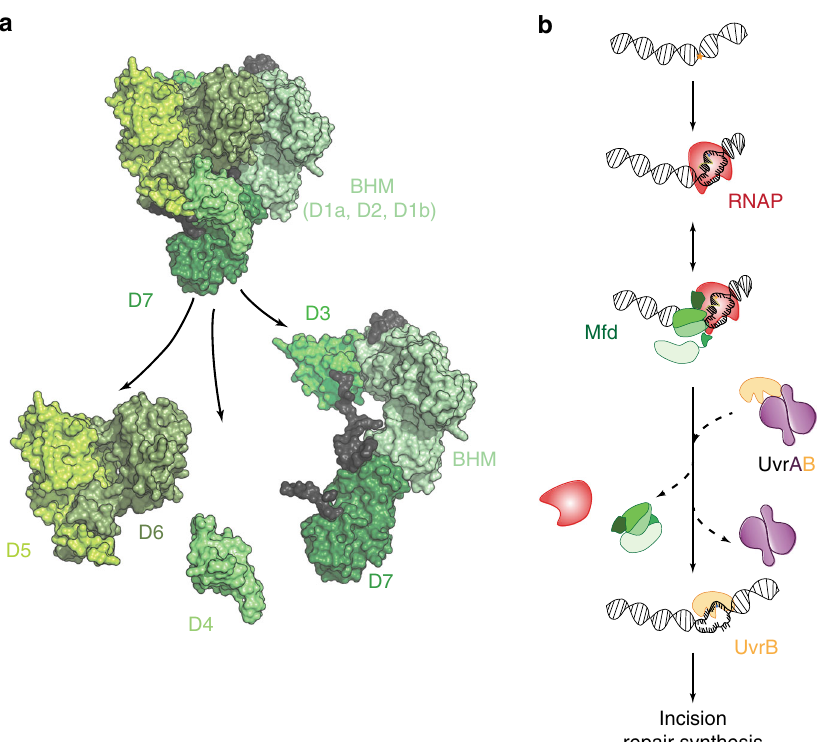
Fig. 1 In vitro model for the initial stages of transcription-coupled repair. a Apo-structure of Mfd (PDB ID: 2EYQ) 9 . The modular Mfd protein consists of seven domains connected by three linkers. The N-terminus (D1a, D2, D1b) is structurally homologous to UvrB and constitutes the UvrB-homology module (BHM). The BHM binds the auto-inhibitory C-terminus (D7) resulting in packing of the RNA polymerase interacting domain (RID; domain 4) against the translocation module that consists of a superfamily 2 helicase (SF2) motor (domains D5-D6). Engagement of stressed transcriptional complexes occurs via RID, resulting in loss of inhibition (reviewed in ref. 54 ). b Ternary elongation complexes stall upon encountering DNA damage in the template strand. According to in vitro models, Mfd engages stalled RNAP and recruits UvrA and UvrB to the site followed by loading of UvrB on the DNA 4,19 . The exact sequence of events in vivo is